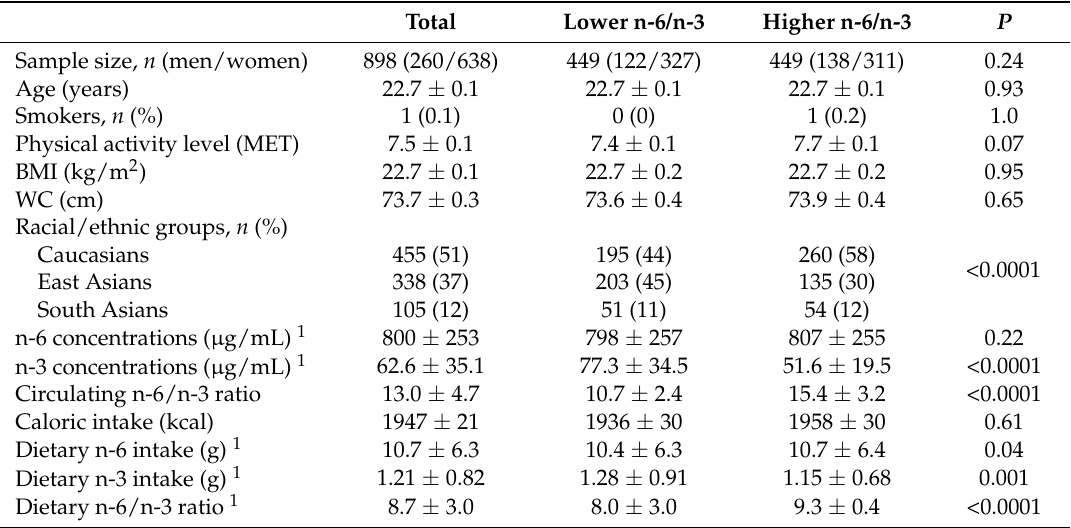
Table 1. Participants’ characteristics according to lower and higher circulating n-6/n-3 ratio ( n = 898). Total Lower n-6/n-3 Higher